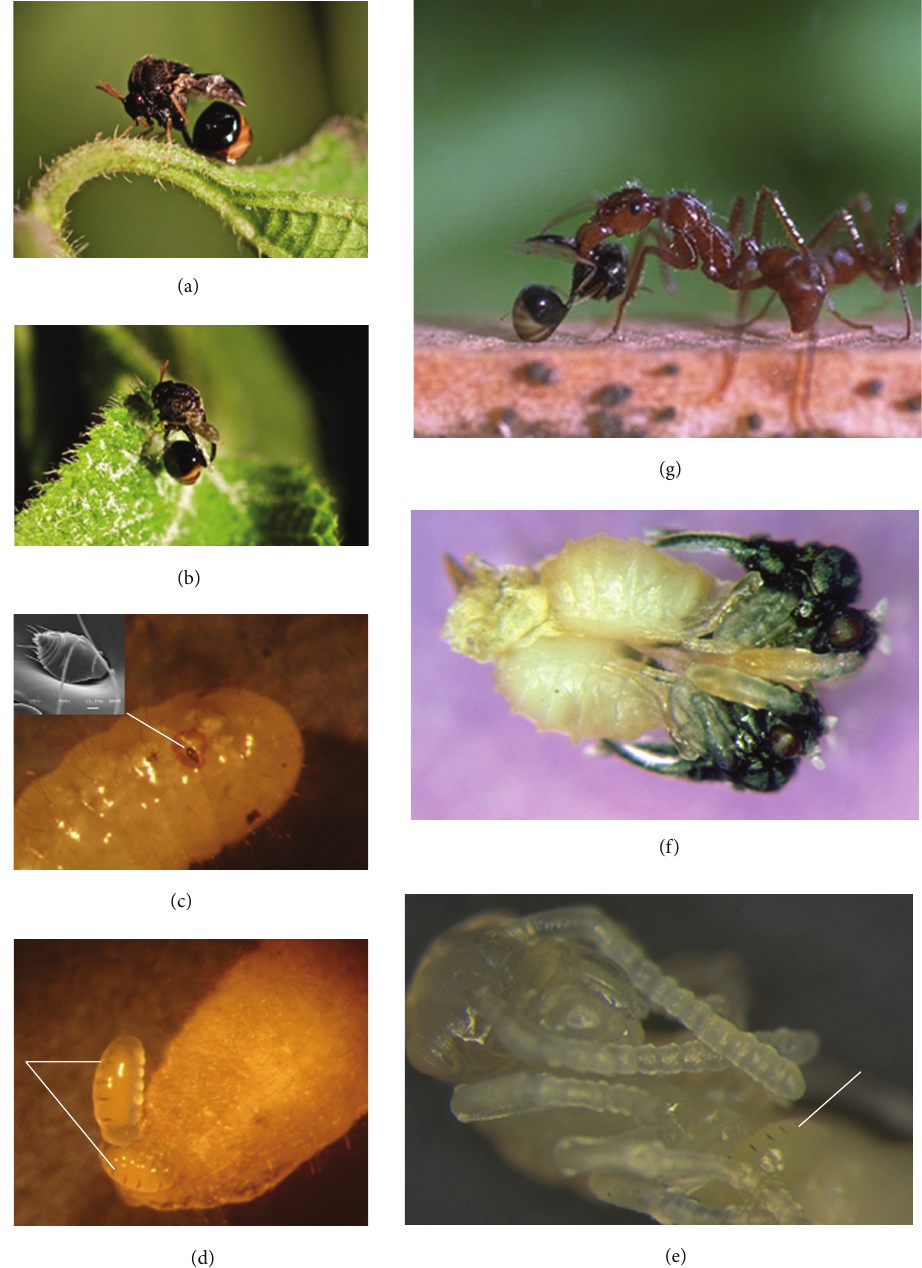
Figure 2: Life cycle of a typical eucharitid wasp. (a) Female Dilocantha lachaudii ovipositing on Lantana camara L. (Verbenaceae). (b) D. lachaudii female with eggs scattered on leaf surface. (c) Planidium (white pointer) attached upon an Ectatomma tuberculatum larva. Insert: SEM picture of a planidium. (d) Two D. lachaudii swollen planidia (white pointers) feeding upon an E. tuberculatum larva. (e) 2nd instar larva (white pointer) relocated after host pupation. (f) Two D. lachaudii pupae from a single host pupa. The host cocoon has been removed. (g) E. tuberculatum worker transporting a recently emerged D. lachaudii female. Photos: J.-P. Lachaud and G.